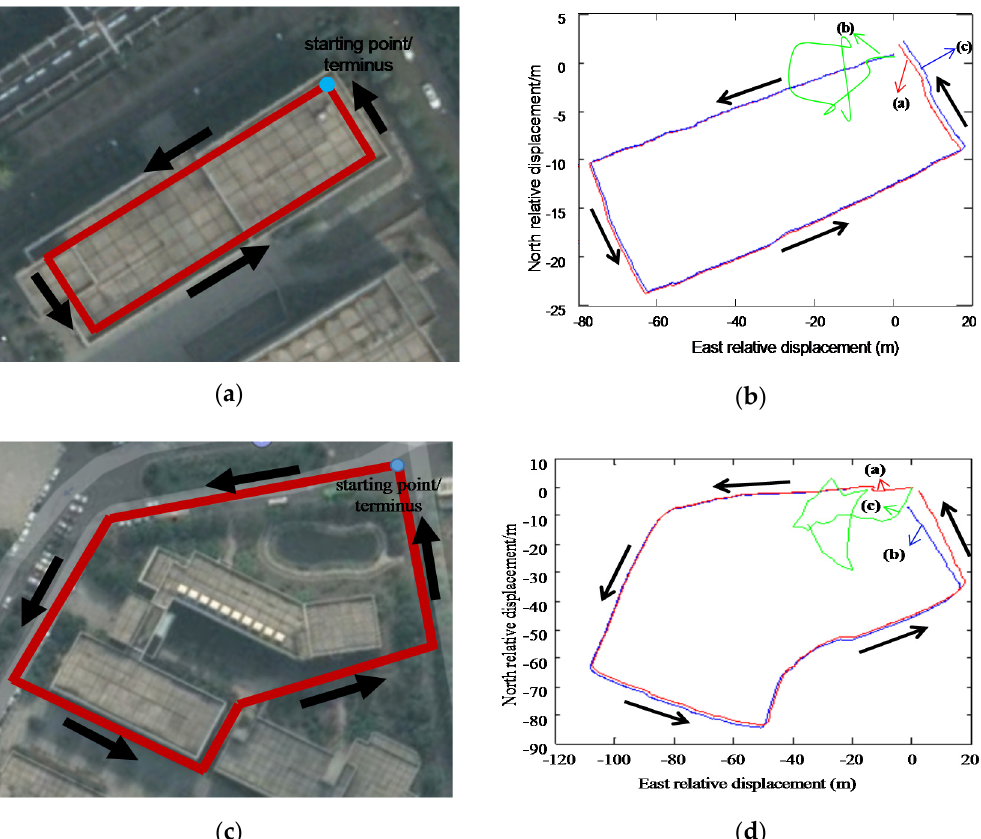
Figure 11. Performance verification experiments of pedestrian navigation methods: ( a ) Indoor pedestrian navigation experiment route; ( b ) Comparison of indoor curves by different pedestrian navigation methods; ( c ) Outdoor pedestrian navigation experiment route; ( d ) Comparison of outdoor curves by different pedestrian navigation methods.